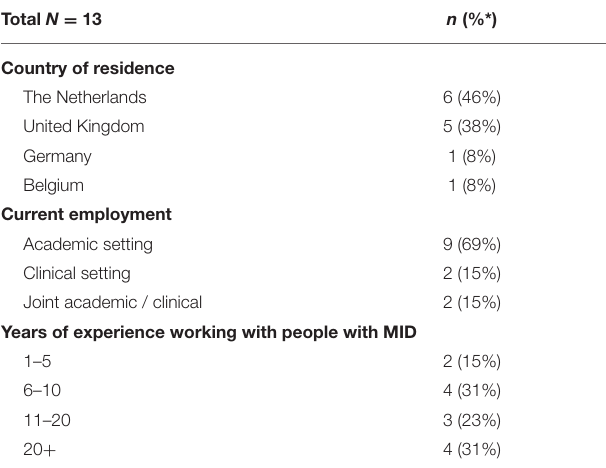
TABLE 1 | Demographic characteristics of experts